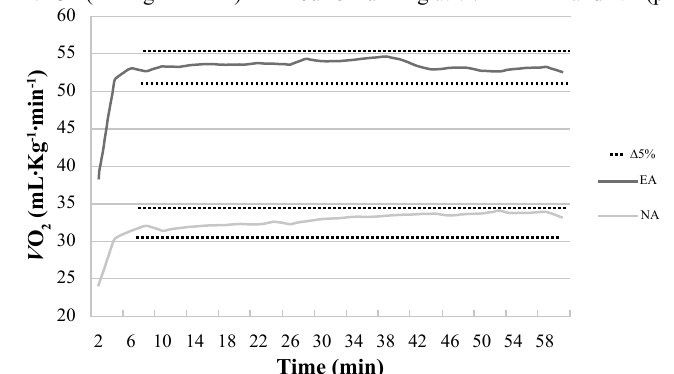
Figure 1− V·O2 (mL·kg-1·min-1) in 1 hour of running at vVAT in EA and NA (p >